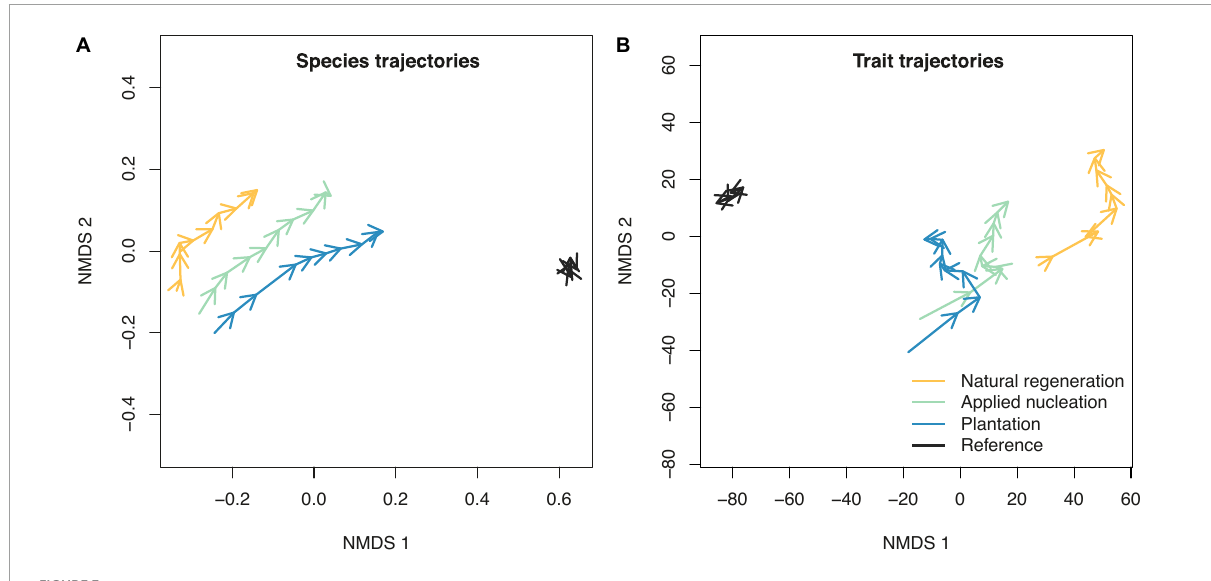
FIGURE3 Community trajectories of non-metric multidimensional scaling (NMDS) fits based on a Bray-Curtis dissimilarity matrix for (A) sapling species composition, and a Euclidean distance matrix for (B) sapling community-weighted mean traits for the restoration treatments and reference forest. The tips of arrows indicate species or trait composition at the end of a